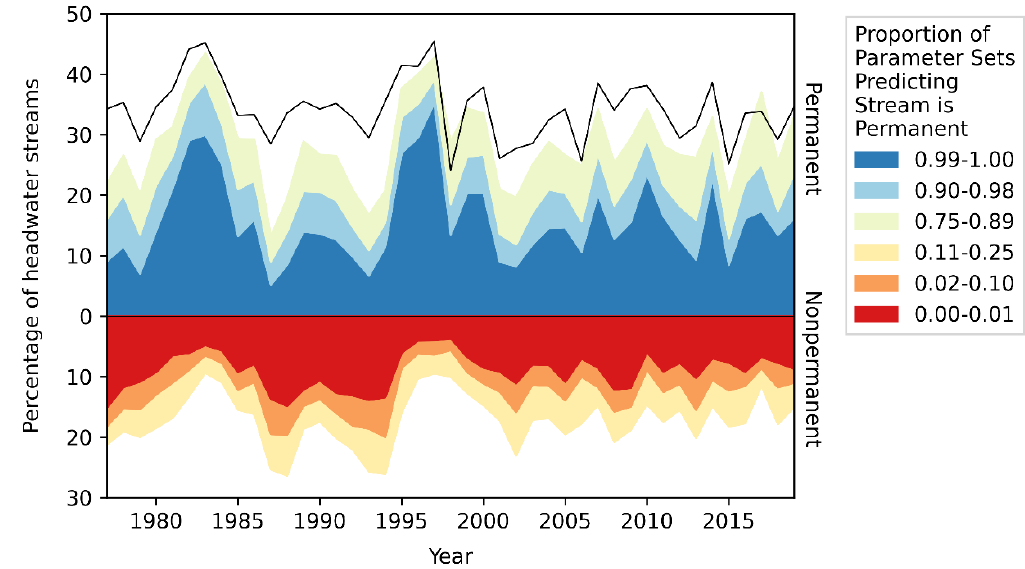
Figure 11. Estimated model precision summed for the entire study area (PNW) for each year of this study. The black line is total percentage of headwater streams with greater than 90% model precision. That is, the sum of the two darkest red and two darkest blue areas on the plot. Darker blue represents greater precision for a permanent classification and darker red represents greater precision for a non-permanent classification.